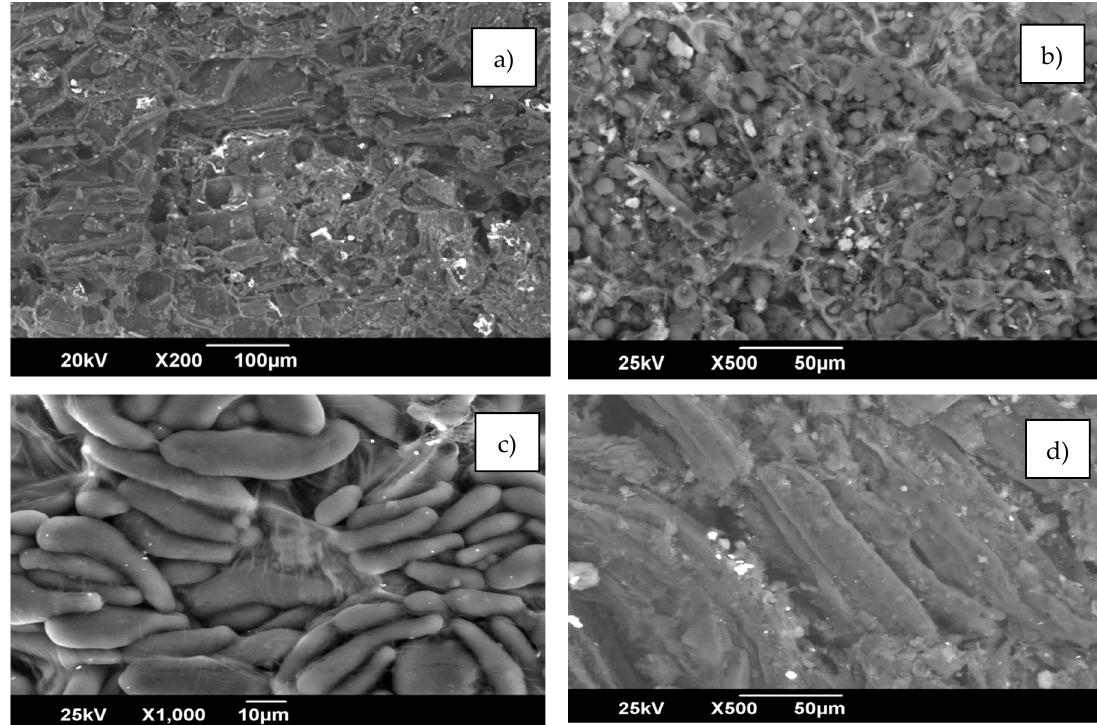
Figure 4. Micrographs from Scanning Electron Microscope after adsorption process: ( a ) YP, ( b ) CP, ( c ) BP, and ( d ) OPB biomasses.